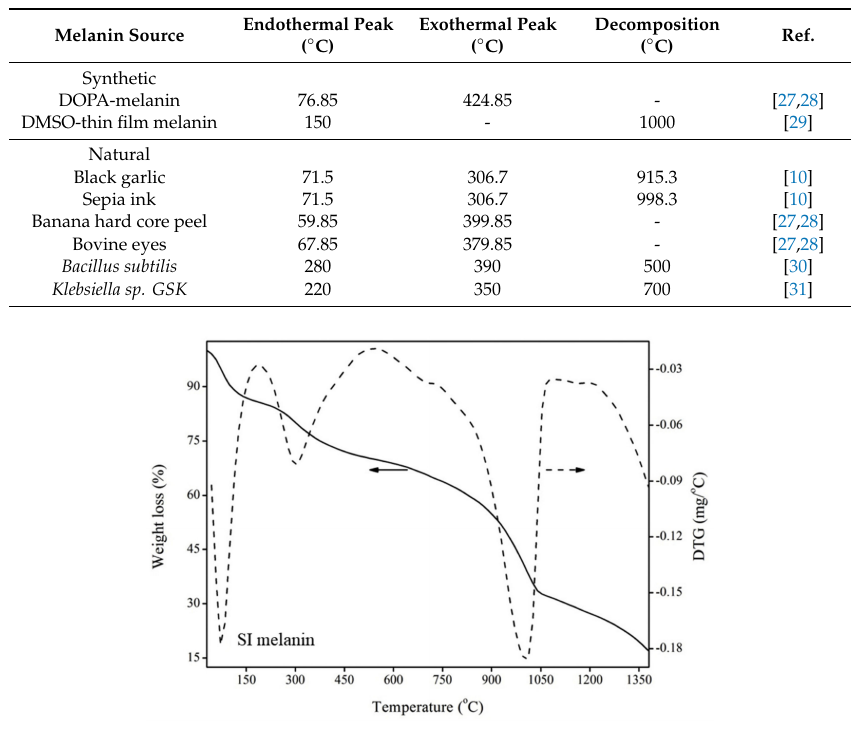
Figure 3. TGA (solid line) and DTG (dotted line) thermogram of melanin isolated from sepia ink (SI melanin) (Partially reproduced with the permission from Ref.